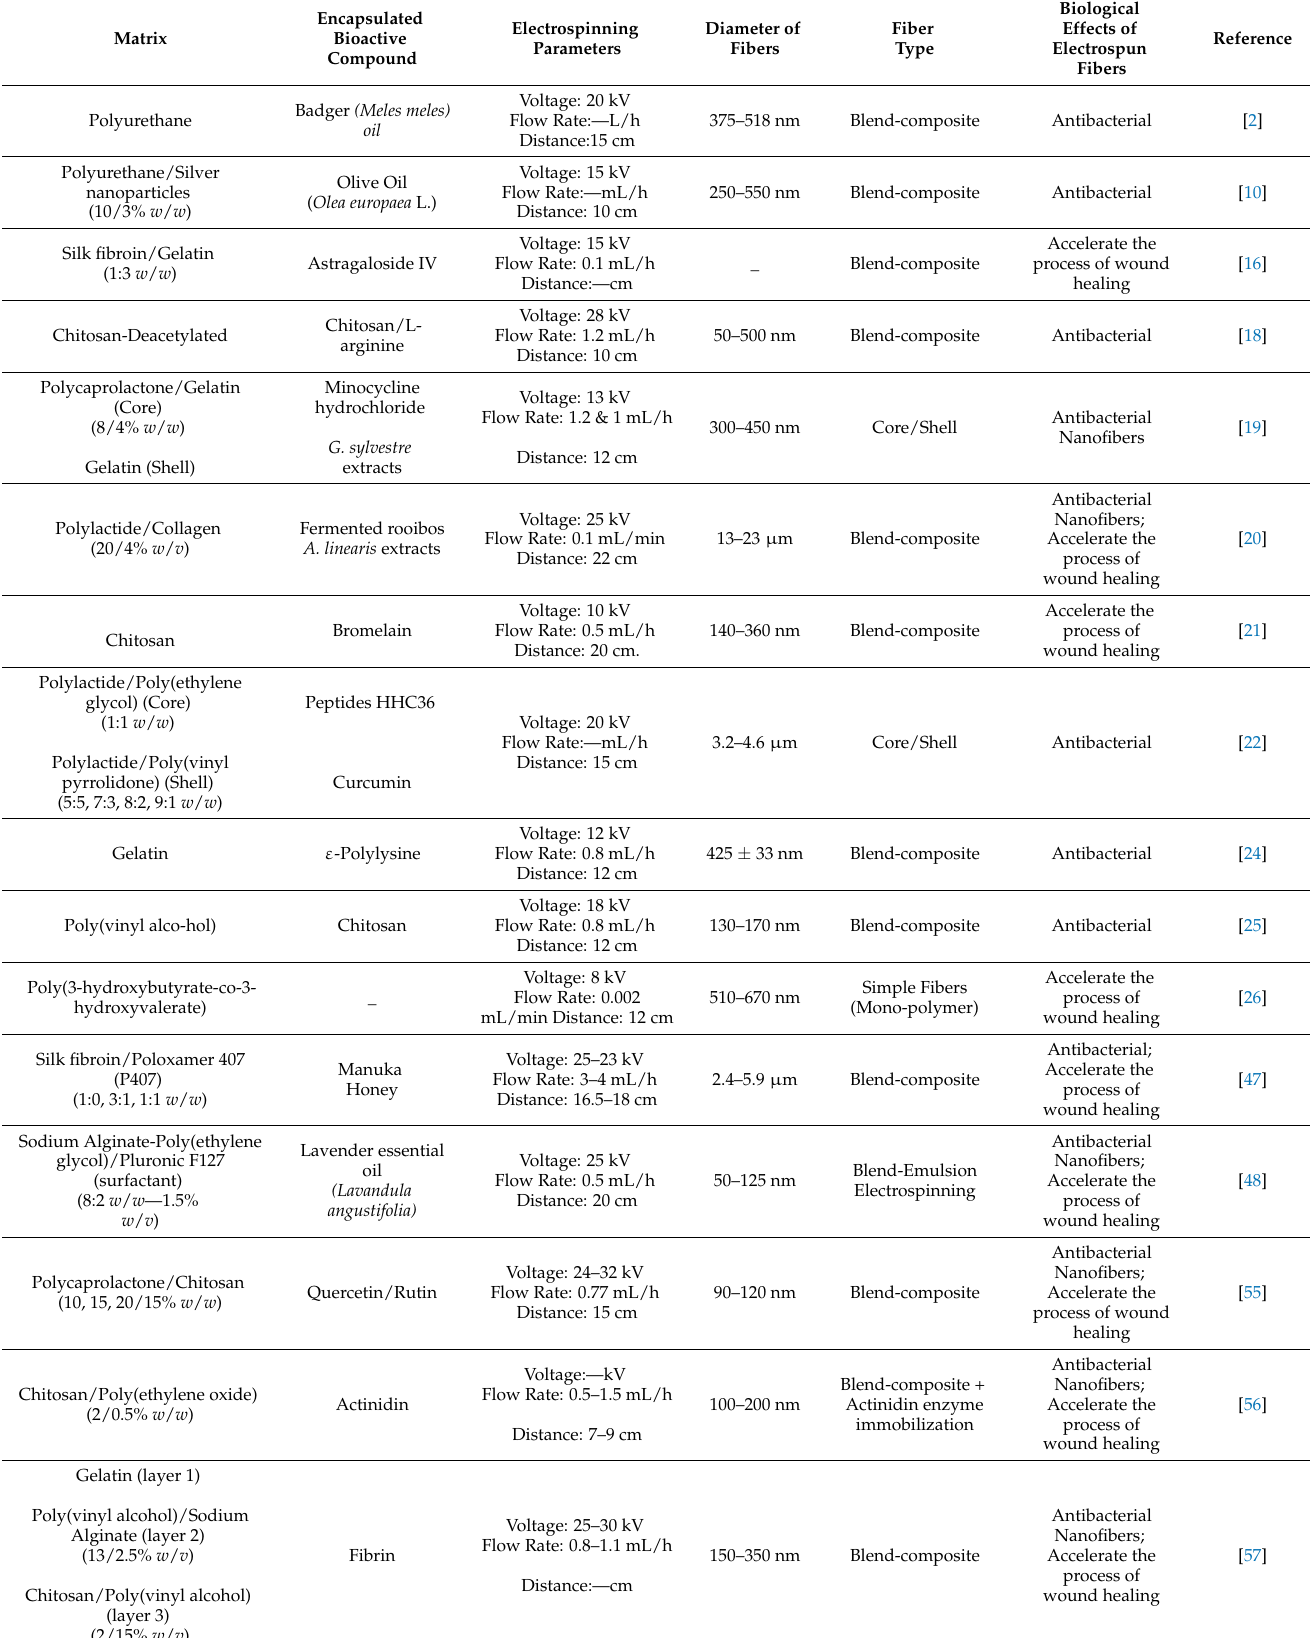
Table 2. Characteristics of electrospun fibers with intended biological effects from 24 articles